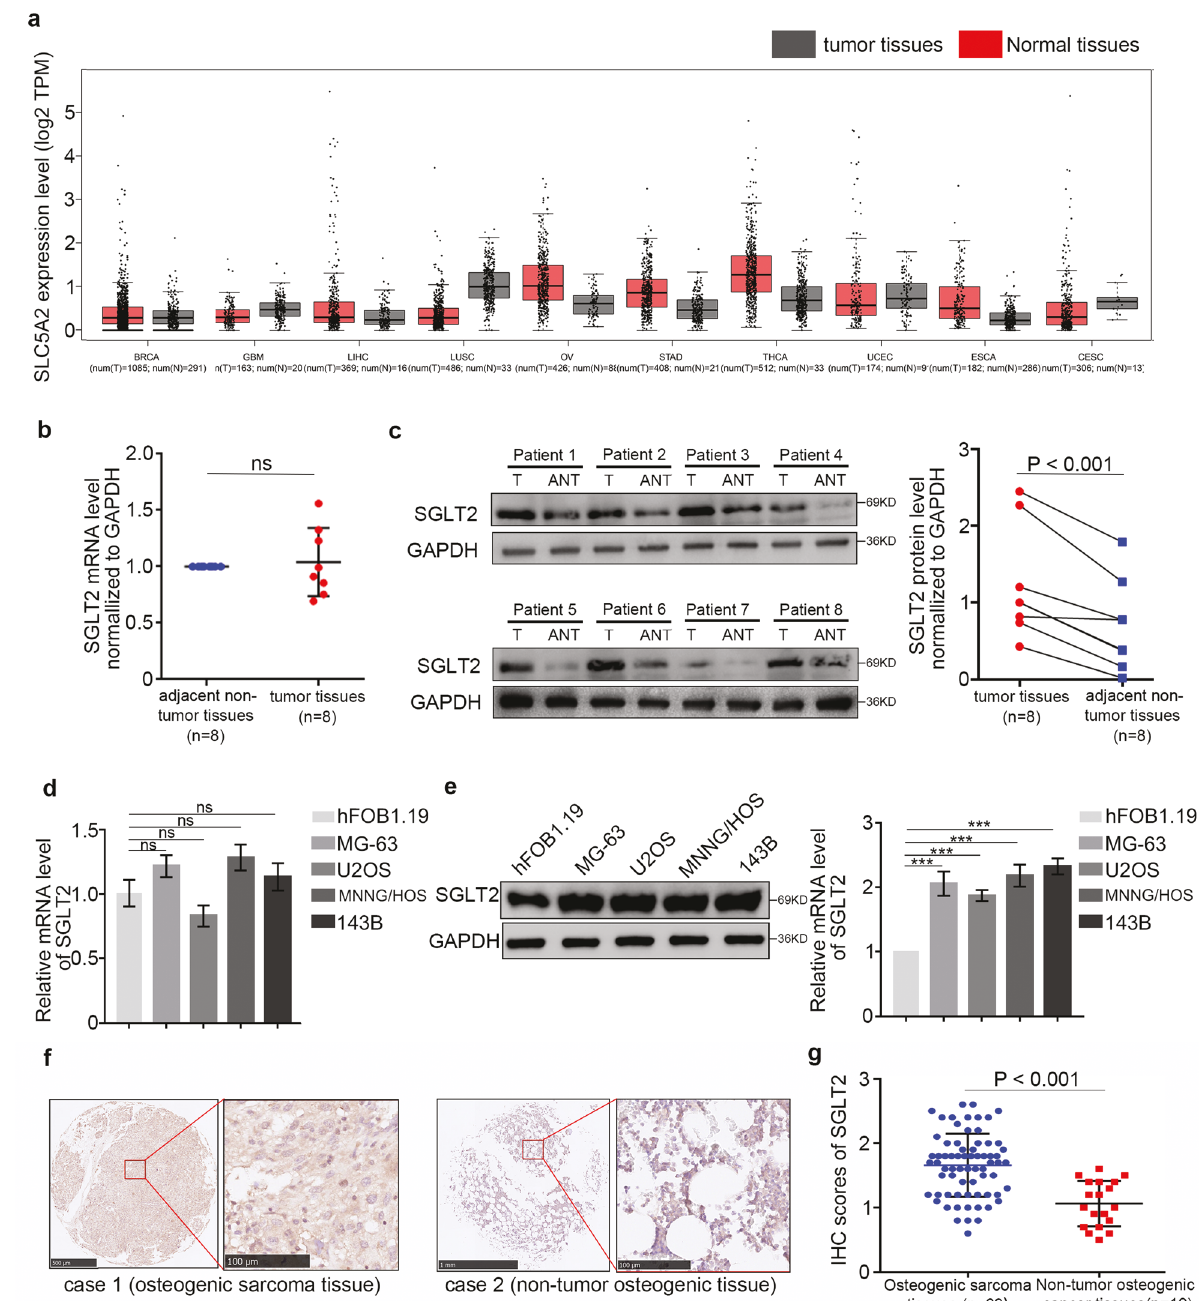
Fig. 1 SGLT2 overexpression at the protein level in osteosarcoma. a Determination of the SGLT2 mRNA expression level by the GEPIA web tool. Boxplot analysis of the expression level showing log2 (TPM + 1) on a log-scale. RT-PCR analysis ( b ) and Western blot analysis ( c ) of the mRNA and protein expression of SGLT2 in eight paired osteosarcoma tumor tissues (T) and the matched adjacent normal tissues (ANT) of the same patient. GAPDH served as an internal reference. d RT-PCR analysis of the mRNA expression of SGLT2 in a normal osteogenic cell line (hFOB1.19 cell line) and four osteosarcoma cell lines (MG-63, U2OS, MNNG/HOS, and 143B cell lines). GAPDH served as an internal reference. e Western blot analysis of the protein expression of SGLT2 in a normal osteogenic cell line (hFOB1.19 cell line) and four osteosarcoma cell lines (MG-63, U2OS, MNNG/HOS, and 143B cell lines). Histogram to show the relative protein level of SGLT2 ( n = 3). GAPDH served as an internal reference. f IHC images of SGLT2-stained Tissue Microarrays (TMAs). Scale bars are shown in the fi gure. g Dot plots of the IHC score of SGLT2 expression of TMA tissue sections (normal osteogenic specimens: n = 19, osteosarcoma specimens: n = 69, p < 0.001). Statistical analyses were performed using the D ’ Agostino and Pearson omnibus normality test. Cell Death and Disease (2022)